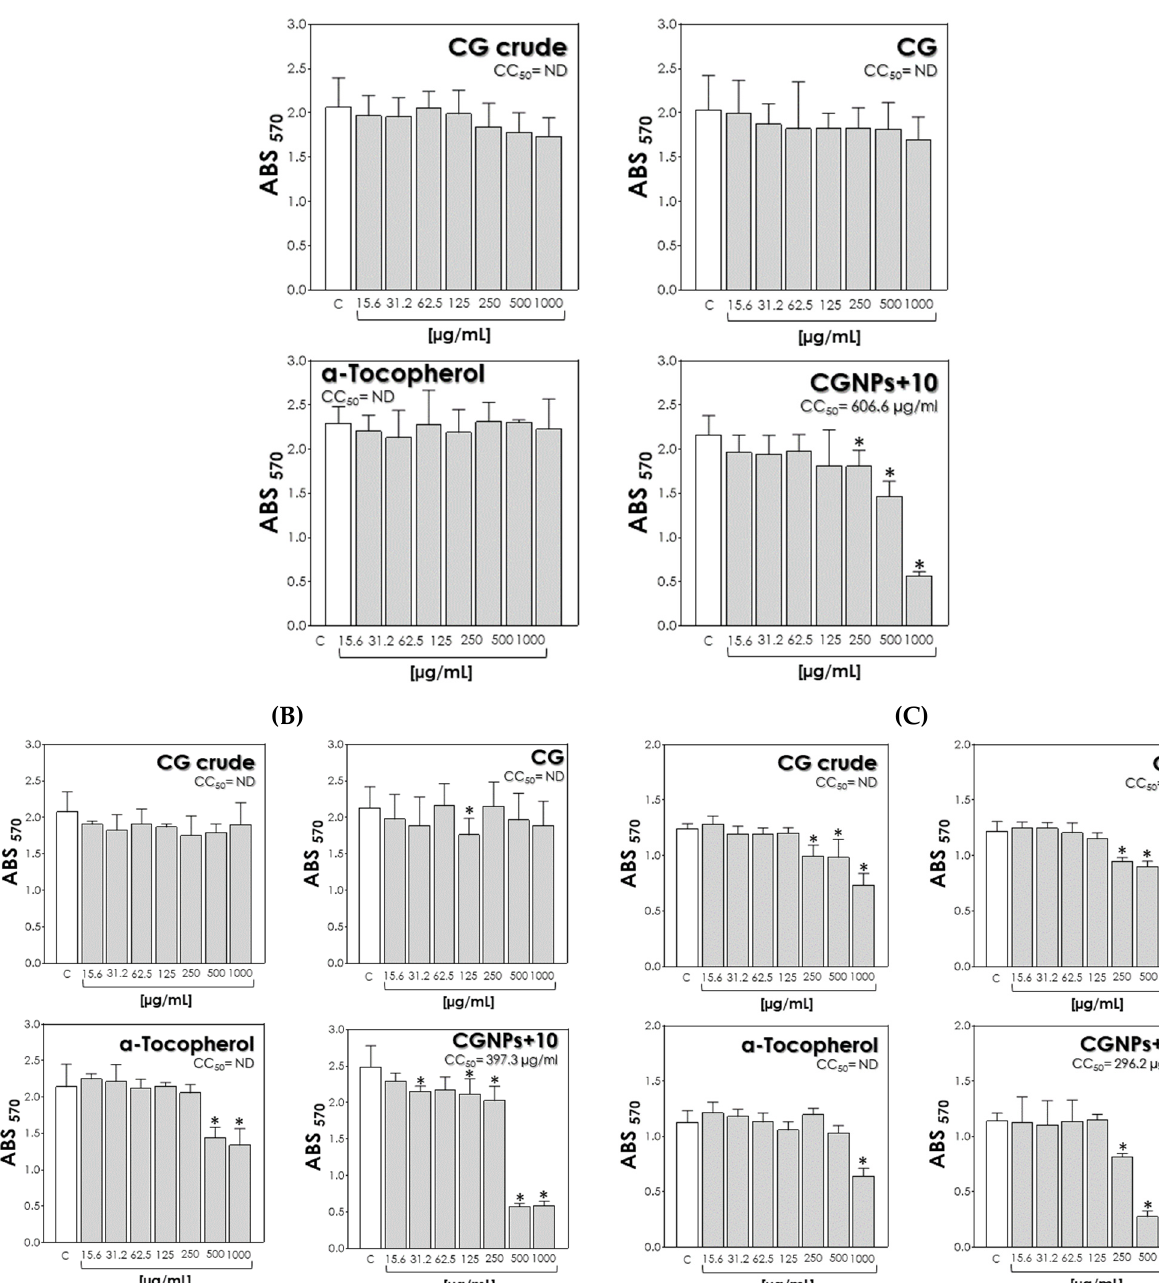
Figure 8. Cell viability of CG crude, CG after purification, α -tocopherol, and CGNPs+10 on ( A ) LLC-MK2, ( B ) HepG2, and ( C ) THP-1(M Φ ). MTT assay was conducted on these cells which were treated with different concentrations of each component for 48 h. The data represents the mean ± standard deviation of n = 3; * significant difference comparing the control ( p < 0.05). CG: cashew gum, CGNPs+10: cashew gum particle with 10% of α -tocopherol.